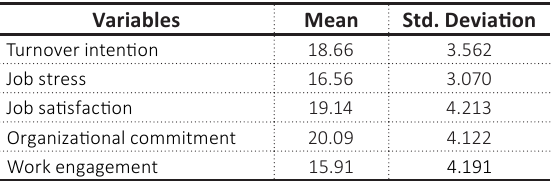
Table 3. Mean and standard deviation